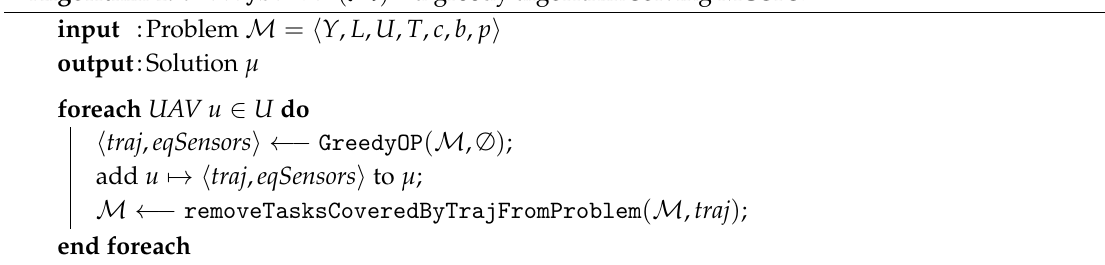
Algorithm 1: GreedySolver ( M ) – a greedy algorithm solving MUSPs.